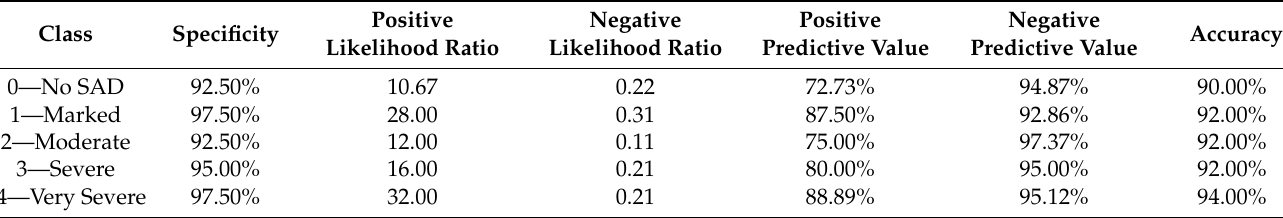
Table 7. Multi-class confusion matrix